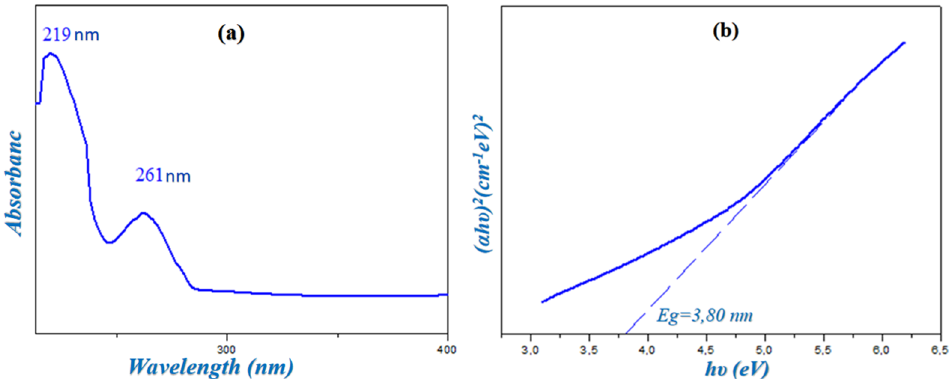
Figure 6. Solution state ultraviolet absorption spectrum of HTN ( a ) and determination of the gap energy obtained via the Tauc model ( b ).